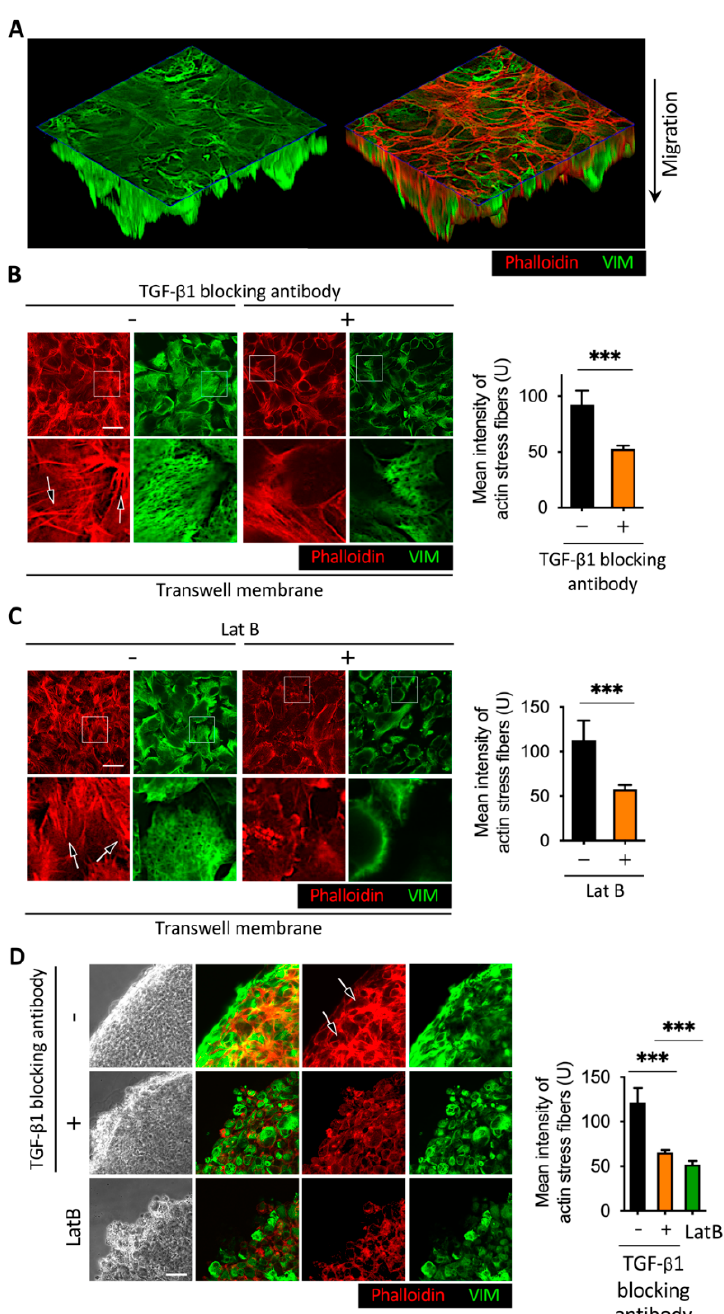
Figure 6. Effect of TGF- β 1 neutralizing antibody and latrunculin B in the Boyden chamber and 3D sphere assay. ( A ) Immunofluorescence images of the Boyden chamber assay. ( B , C ) Images of representative immunofluorescence results revealed that the addition of TGF- β 1-blocking antibody or latrunculin B reduced actin stress fibers and vimentin intermediate filament networks. BFTC909 cells were seeded in the Boyden chamber overnight, followed by migration for 48 h. A detachment assay was performed with or without treatment of TGF- β 1 ligands or latrunculin B for another 48 h. Scale bars: 10 µ m. *** p < 0.001. Data are means ± s.d. (two-tailed t test) from experiments with three replicates ( n = 3). ( D ) Treatment of TGF- β 1-blocking antibody or latrunculin B repressed actin stress fibers and vimentin intermediate filament networks in BFTC909. A three-dimensional sphere assay was performed with or without treatment of TGF- β 1-blocking antibody or latrunculin B for 48 h. Black arrow: actin stress fibers. Scale bars: 10 µ m. *** p < 0.001. Data are means ± s.d. (one-way ANOVA with Dunnett’s multiple comparisons test) from experiments with three replicates ( n = 3). LatB, latrunculin